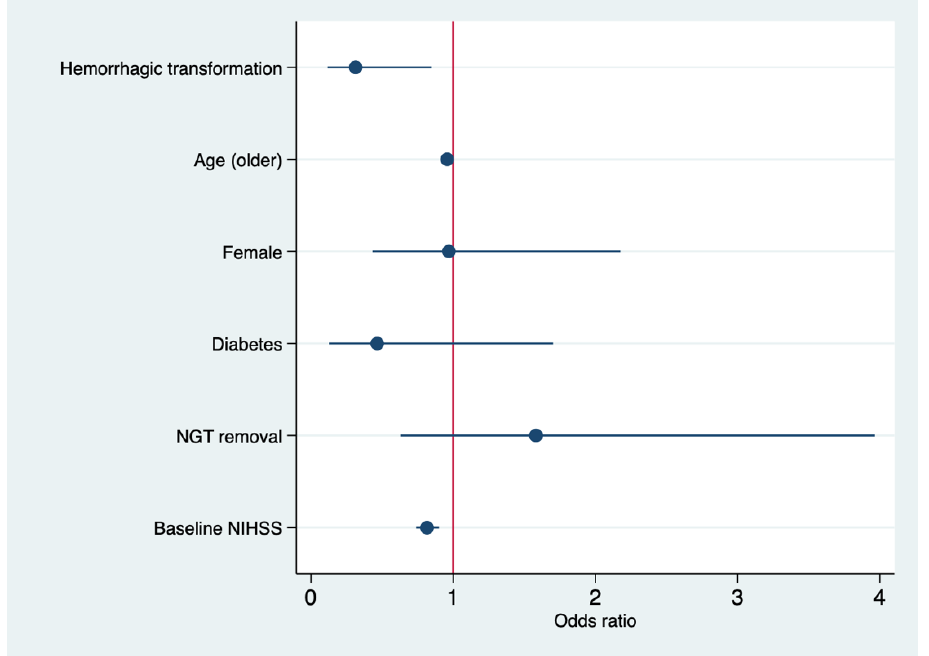
Figure 3. Forest plot showing odds ratios of all clinical variable included in the predictive model for a 180-day good